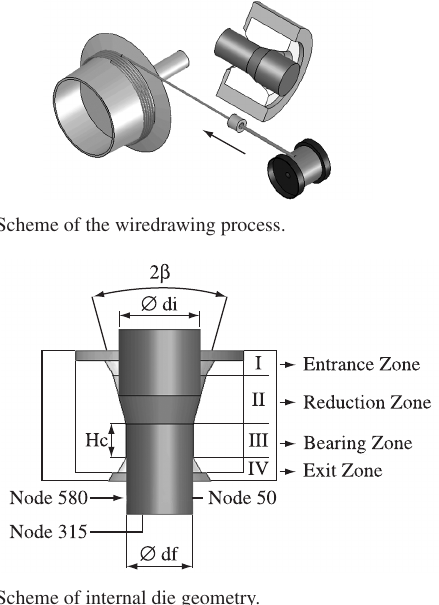
Figure 2. Scheme of internal die geometry.